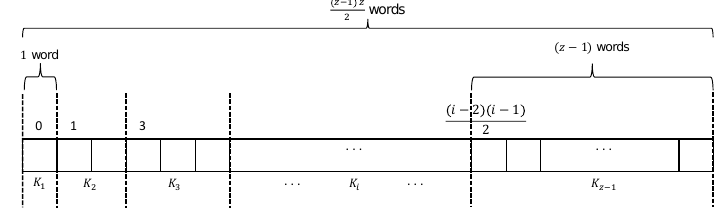
Efficiency of Garner’s Algorithm on GPU Garner’s CRT-reconstruct is more suited